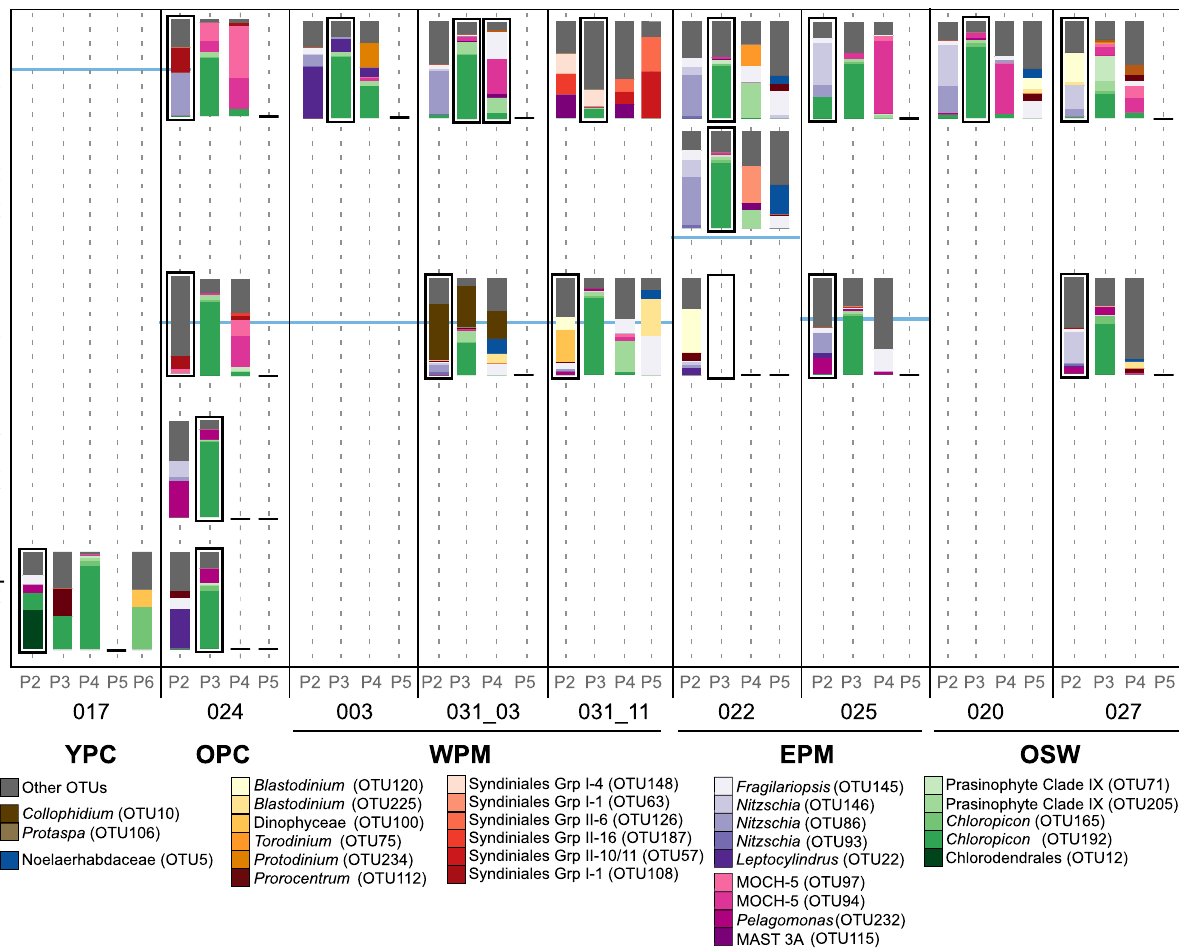
Figure 5. Relative contribution of the major OTUs to each population. OTU compositions are represented as barplots. The most abundant population in each sample is indicated by a black border around the corresponding barplot. Note that the sample for cell counts at S033 was lost, so no data are shown for this sample. Empty barplots indicate missing 18S rDNA data due to low DNA concentrations or low quality reads. The blue lines indicate the position of the halocline. “Other OTUs” indicate OTUs that only contributed less than 20% of a population in any given sample. Grp., group; OTU, operational taxonomic unit; MOCH, Marine Ochrophyta; MAST, Marine